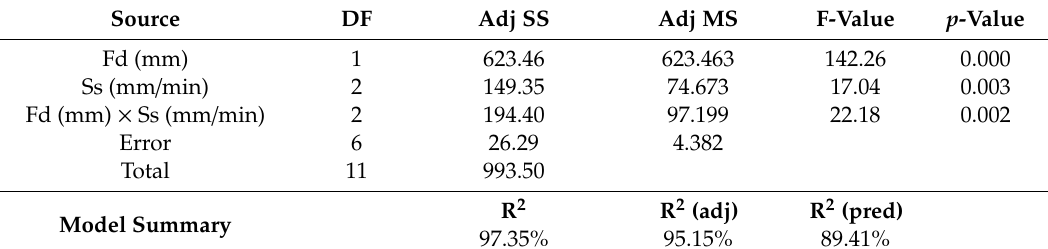
Figure 12. Roughness parameters vs. laser parameters. Table 7. Analysis of variance results for